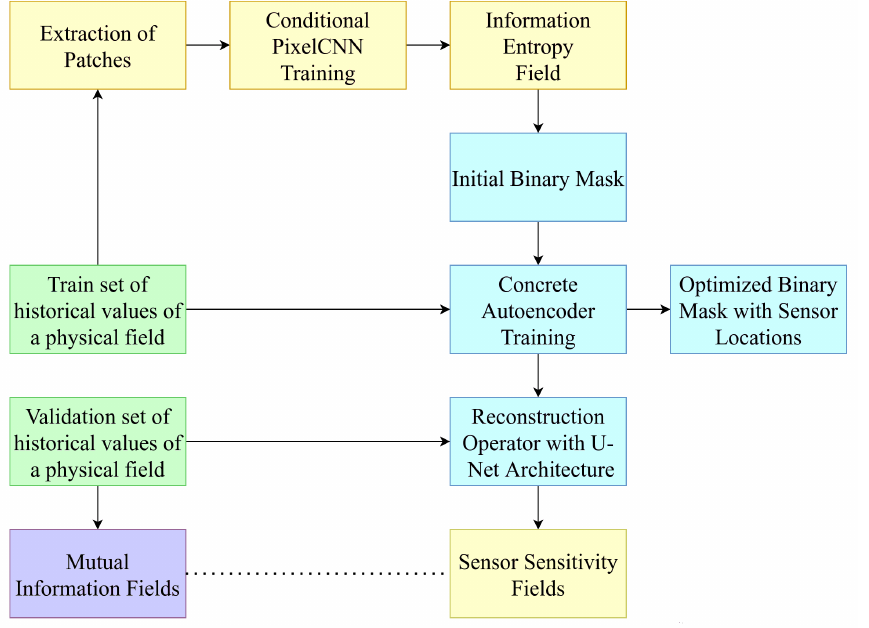
Figure 1. Dependence scheme of the developed methods in the general process of optimizing the sensor placement and finding its area of influence. The orange blocks describe the information entropy approximation. The blue blocks correspond to the optimization of sensor placement using a Concrete Autoencoder. The yellow block corresponds to the sensitivity analysis method, which utilizes a trained Concrete Autoencoder. The purple block describes the methods of assessing the sensitivity of a sensor with the help of mutual information. The green blocks indicate the input